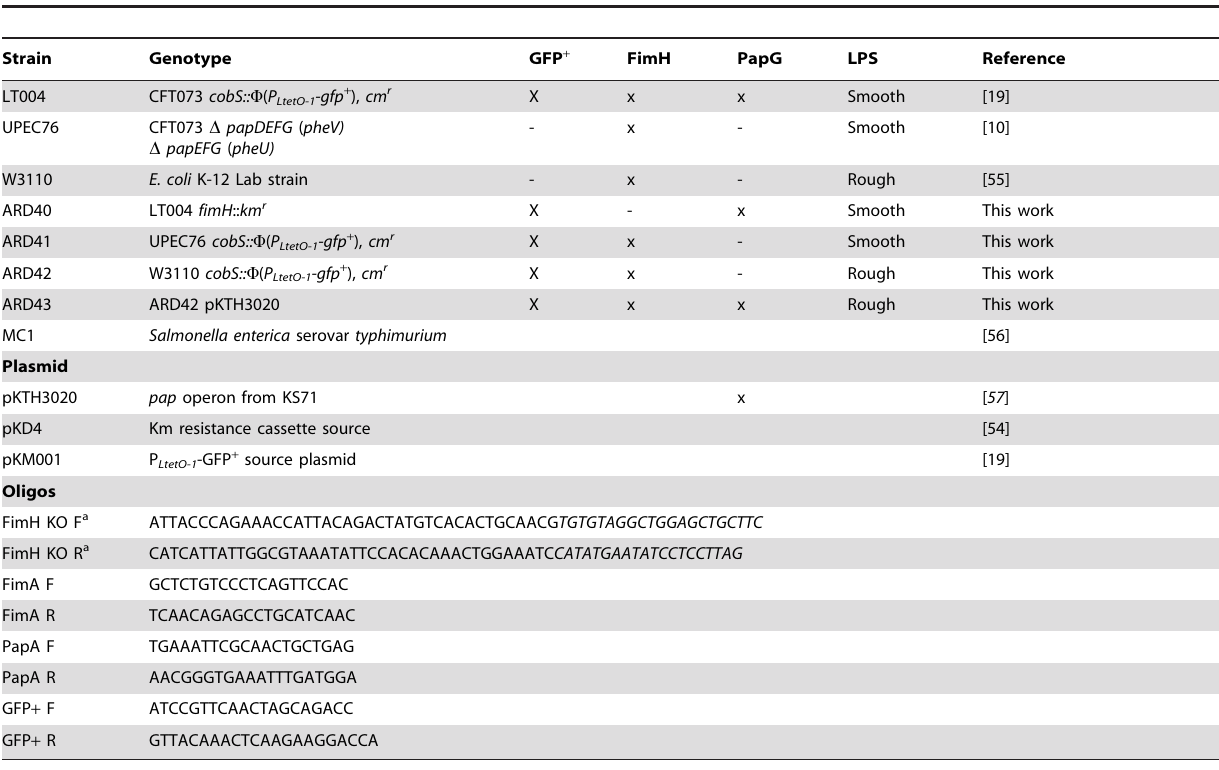
Strain Genotype GFP + FimH PapG LPS Reference LT004 CFT073 cobS:: W ( P LtetO-1 -gfp + ), cm r X x x